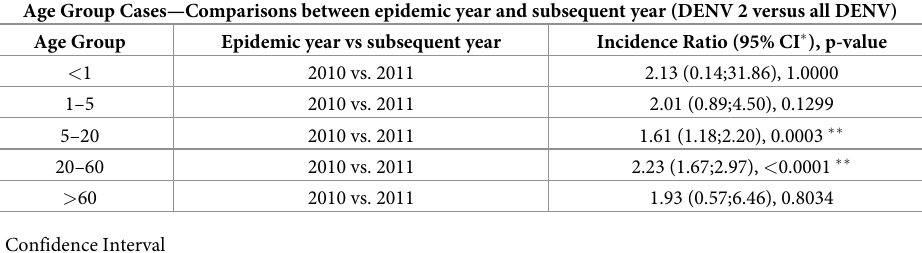
Table 1. Incidence ratio of cases in each age group in 2010, the year with the major DENV 2 epidemic, and in 2011. Age Group Cases—Comparisons between epidemic year and subsequent year (DENV 2 versus all DENV)